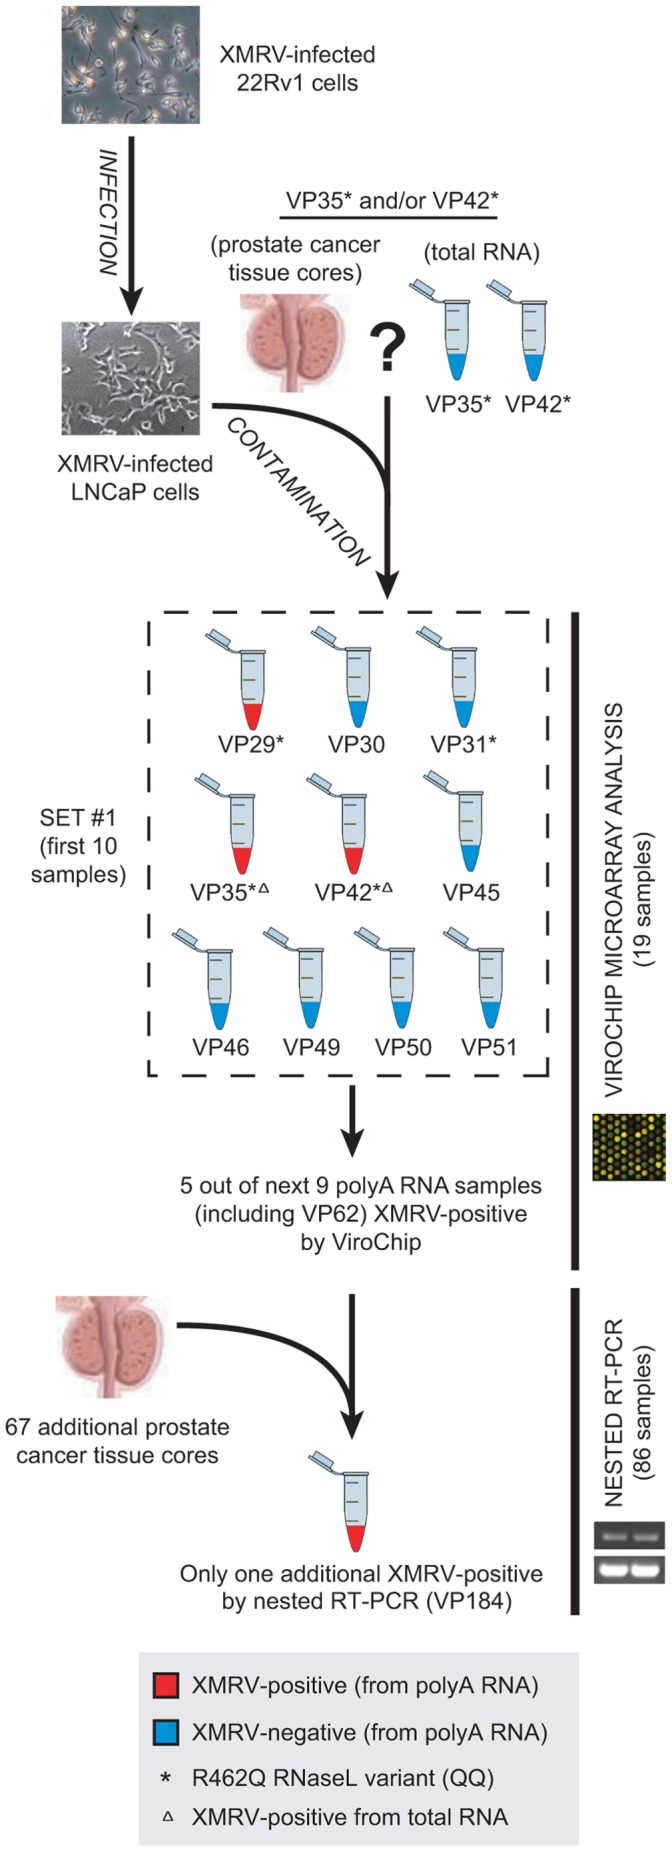
Proposed Model for Laboratory Contamination by XMRV.Early contamination of VP35/VP42 prostate cancer tissues and/or extracted RNA by XMRV-infected LNCaP cells resulted in mistaken identification of XMRV in association with prostate cancer.